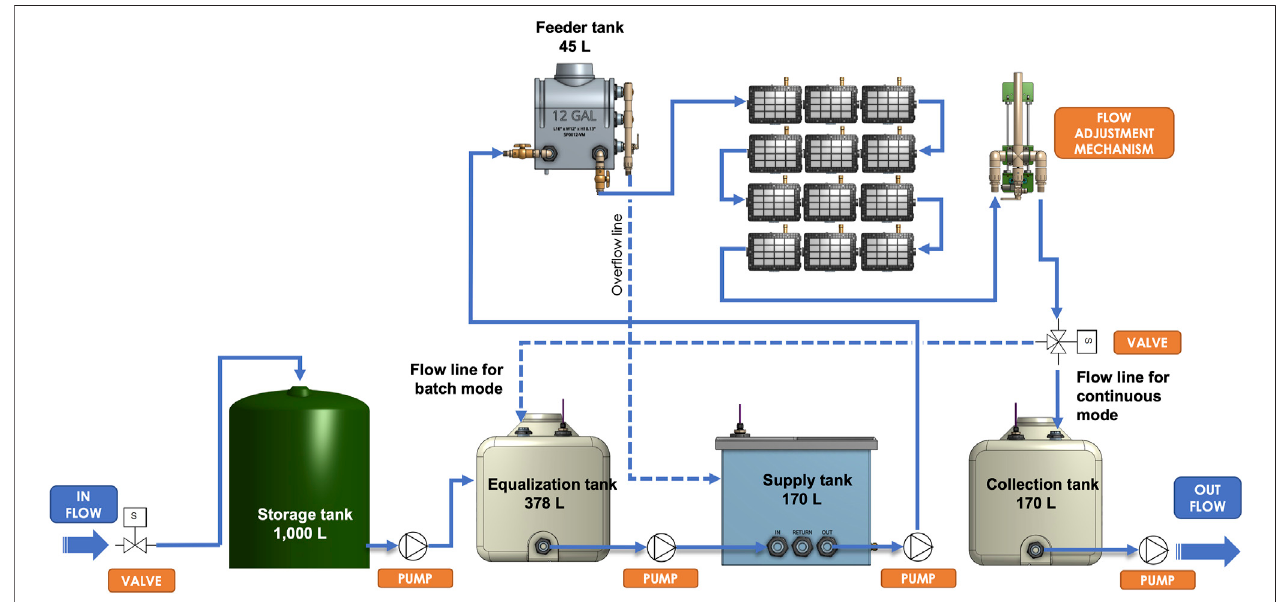
FIGURE 1 | Hydraulic diagram of BETT Demo Unit.